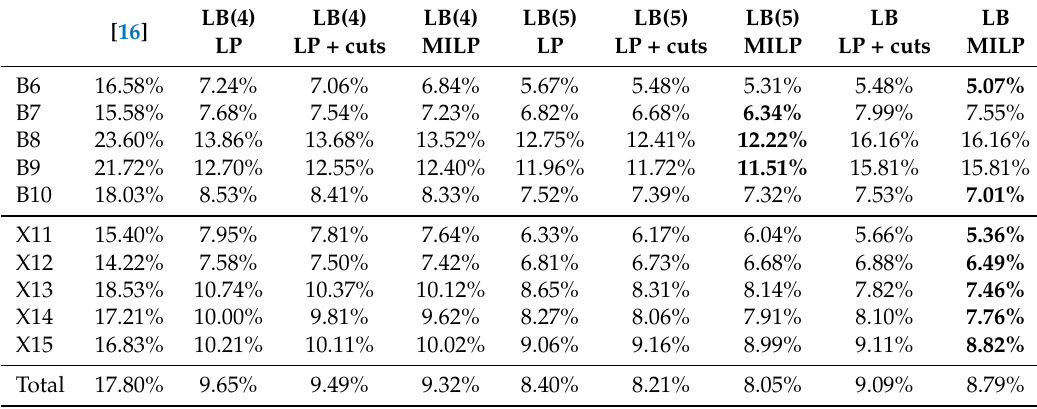
Table 10. Dual bounds for datasets B and X, computing LB ( k 0 ) with k 0 > 3 and LB bounds with M = 1 scenario decomposition, using truncated LP, LP+cuts, and MILP